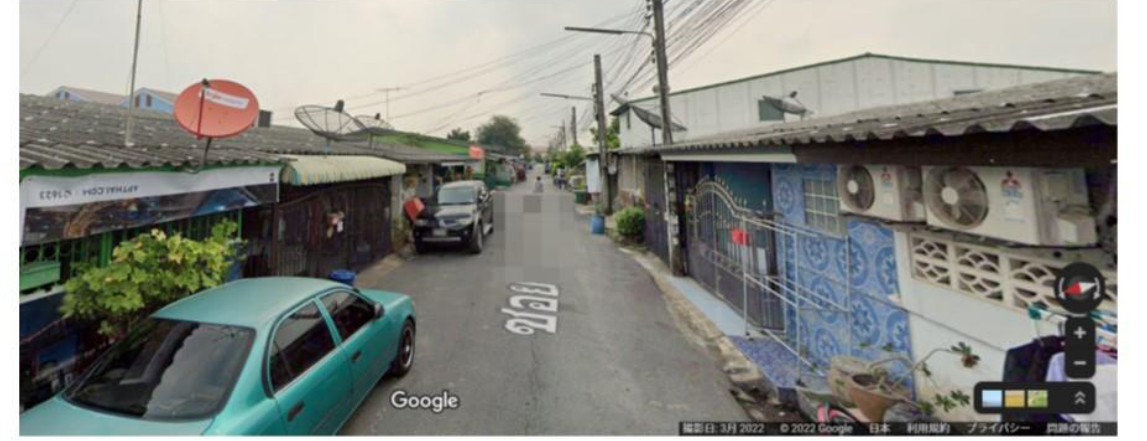
Figure 6. Google street view of the hottest residential area (area 27, Figure 4) in March 2022. Wavy slate is widely used as the roofing material. The roads are covered with asphalt